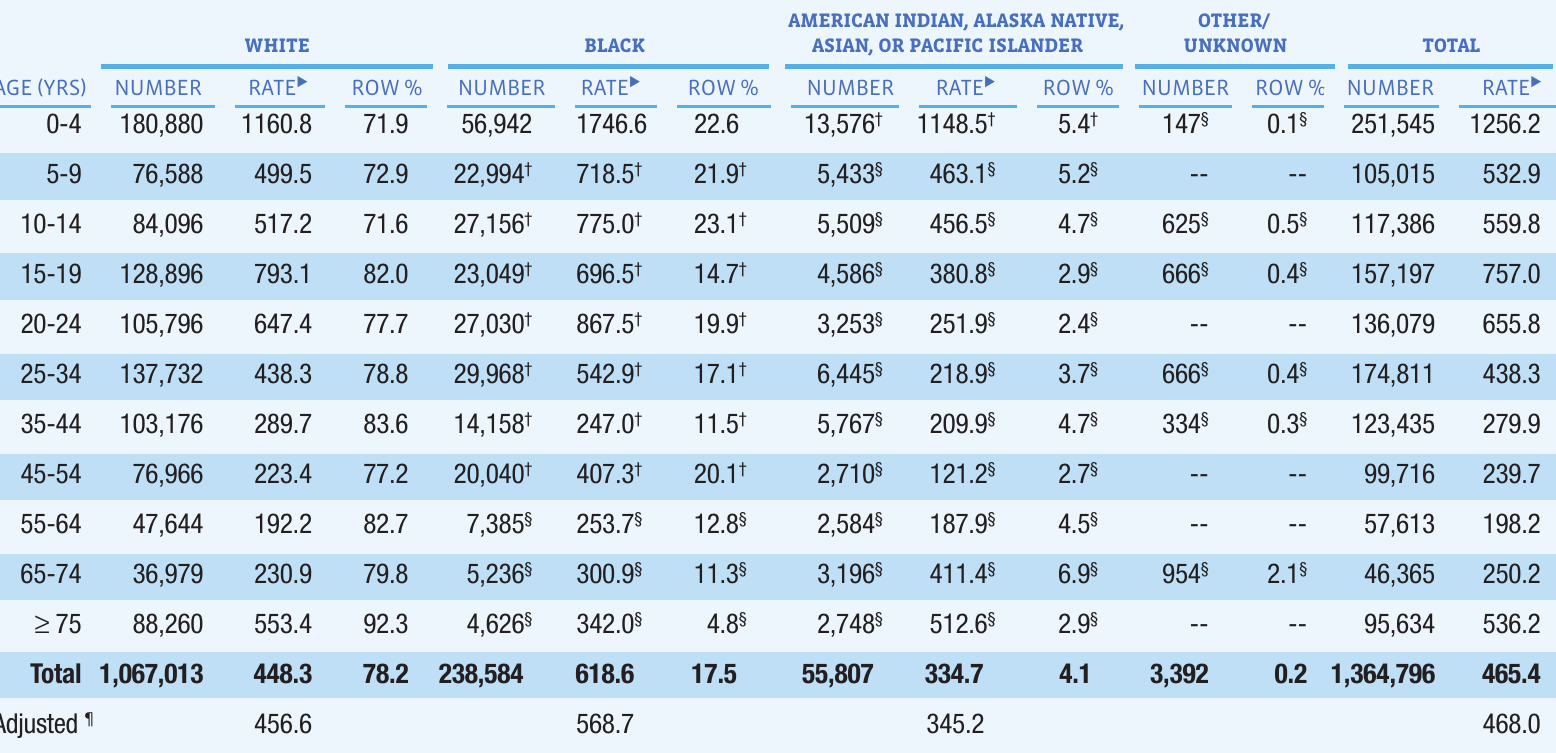
TABLE 4: Estimated Average Annual Numbers, Rates, and Percentages of Traumatic Brain Injury-Related Emergency Department Visits, by Age Group and Race, United States, 2002–2006